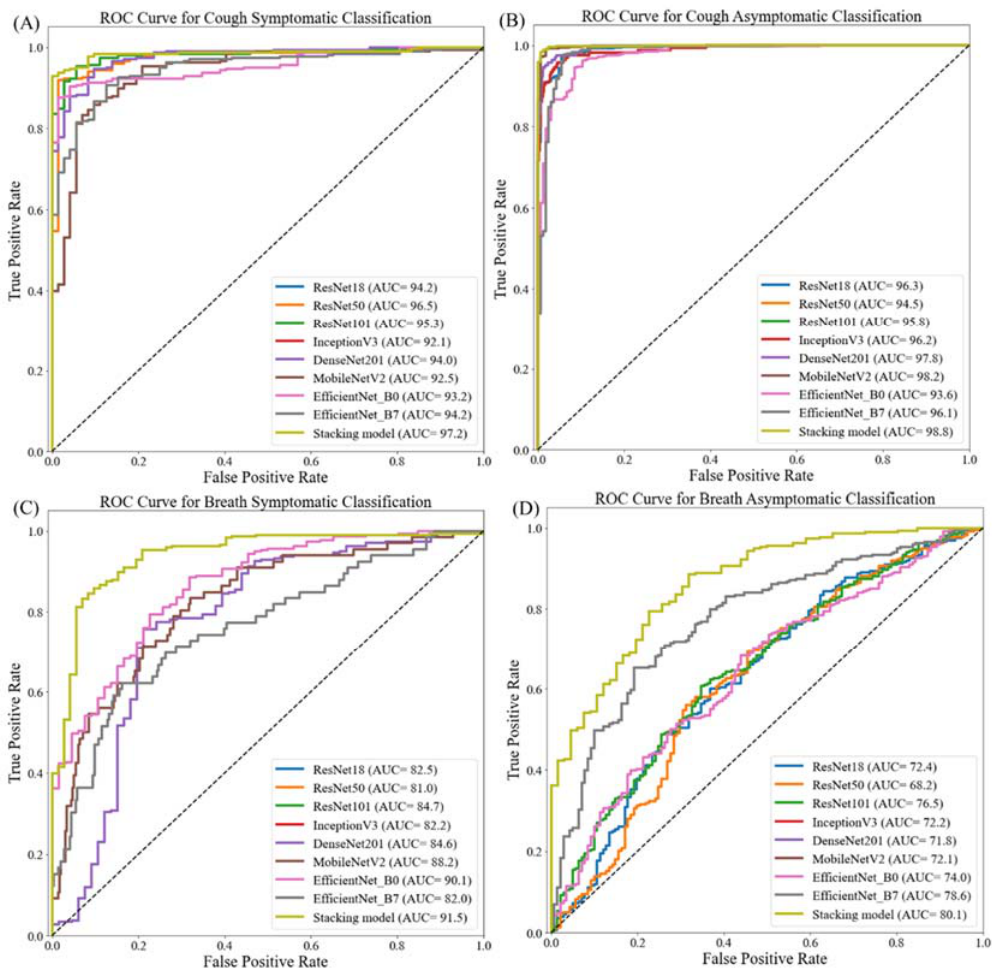
Figure 4. ROC curve for healthy and COVID-19 patients’ classification using cough sounds for ( A ) symptomatic patients and ( B ) asymptomatic patients, and using breath sounds for ( C ) symptomatic patients and ( D ) asymptomatic patients.